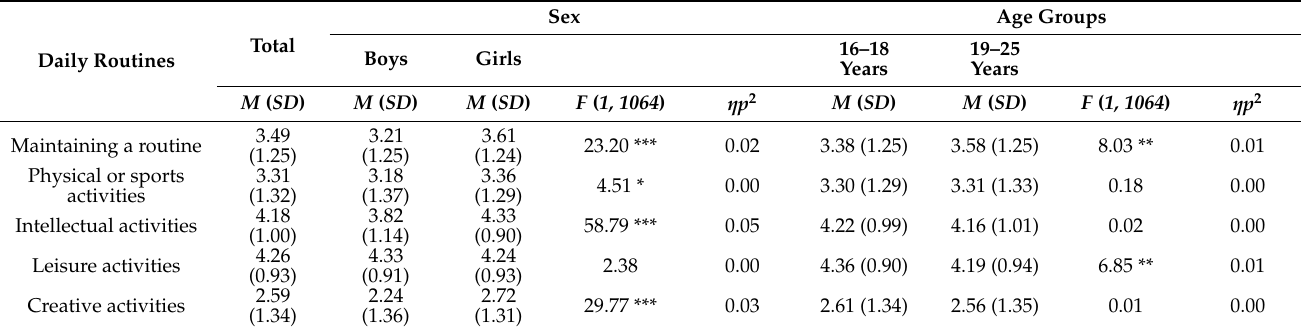
Table 2. Descriptive and MANOVA statistics for daily routines by sex and age